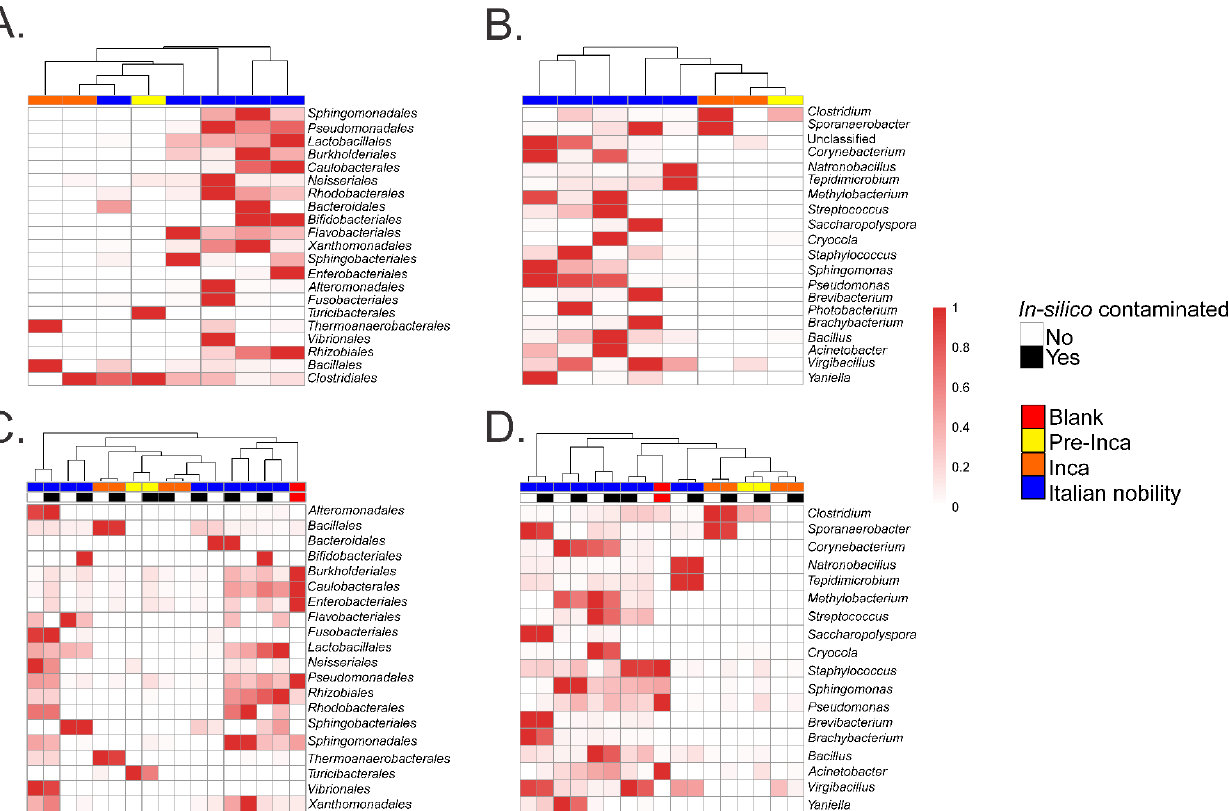
Figure 3. Heatmap of relative abundances of selected taxa. Results show the relative abundances of selected OTUs at the order ( A ) and genus level ( B ). Values were plotted after filtering OTUs present in the blank control from the mummified microbiome (see text). Results also show the relative abundances of selected OTUs at the order ( C ) and genus level ( D ) of the in-silico contaminated samples (see text) compared to the filtered samples.